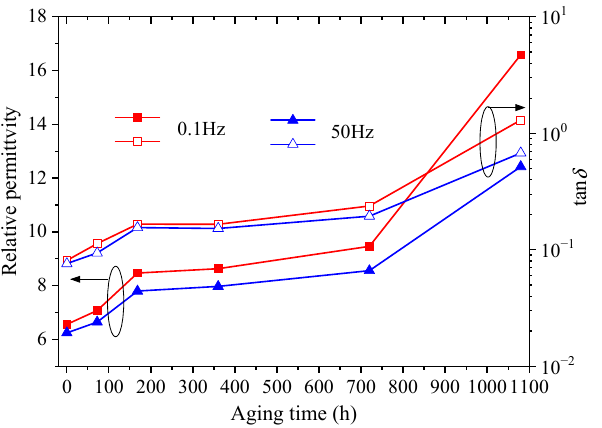
Figure 2. Relative permittivity and loss tangent (tan δ ) of aged SiC/epoxy micro-composites under 0.1 and 50 Hz.